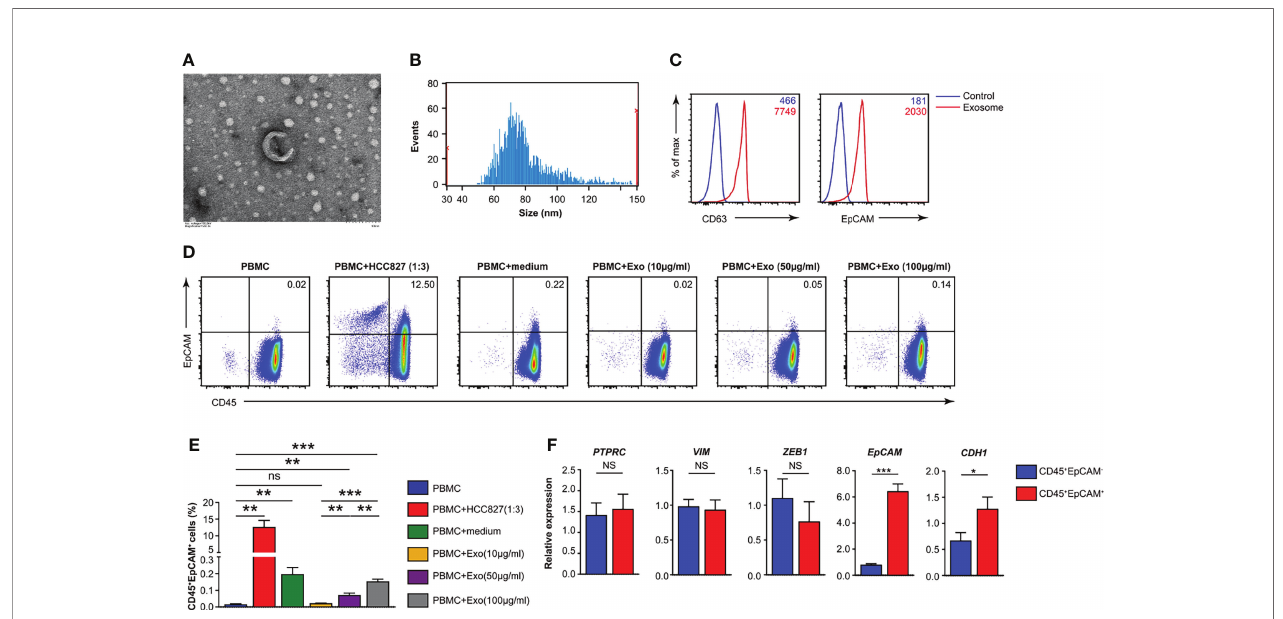
FIGURE 4 | HCC827 cell-derived exosomes play a critical role in CD45 + EpCAM + cell formation. (A) Representative TEM pictures of HCC827 cell-derived exosomes. Scale bar: 100 nm. (B) Nanoparticle tracking the size distribution of HCC827 cell-derived exosomes. (C) Detection of protein levels of CD63 and EpCAM in HCC827 cell-derived exosomes by fl ow cytometry (representative of 3 independent experiments). (D, E) Flow cytometry analysis of CD45 + EpCAM + cells from PBMCs cocultured with HCC827 cells, cultured with HCC827 cell media, or with HCC827 cell-derived exosomes (10, 50, and 100 µg/ml) for 24 h. Analysis of CD45 + EpCAM + and CD45 + EpCAM − cells was from the same sample, and 5 × 10 5 live cells were analyzed for each sample. Representative pseudocolor plot and cumulative data are demonstrated in (D, E) , respectively ( n = 3). (F) Quantitative RT-PCR analysis of epithelial and mesenchymal marker genes described as above in CD45 + EpCAM + and CD45 + EpCAM − cells from PBMCs cultured with HCC827 cell conditioned media ( n ≥ 4). Data are representative of at the latest three separate experiments. Error bars delegate SEM. * P < 0.05, ** P < 0.01, and *** P < 0.001 (Student ’ s t -test). NS, no signi fi